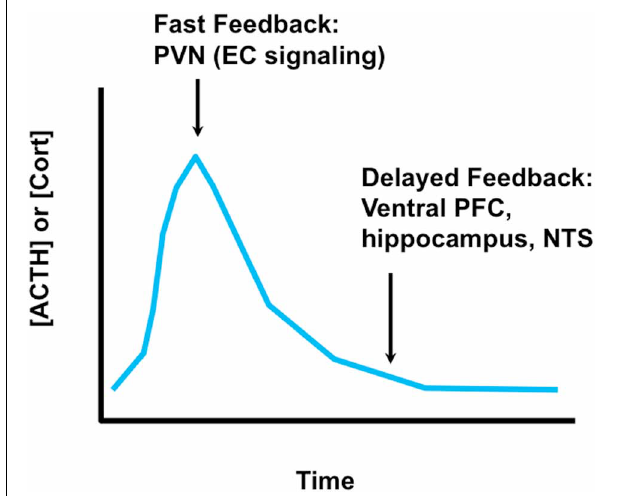
FIGURE 2 | Time domains of glucocorticoid feedback. Fast glucocorticoid feedback occurs in the realm of minutes to seconds, and likely involves membrane effects of glucocorticoids on endocannabinoid synthesis at the PVN. Delayed feedback controls return of glucocorticoid levels to baseline, and likely involves glucocorticoid feedback signals at multiple brain regions, including the prefrontal cortex, ventral subiculum (hippocampus) and possibly the nucleus of the solitary tract. It is not clear whether delayed feedback is genomic, non-genomicor a combination of